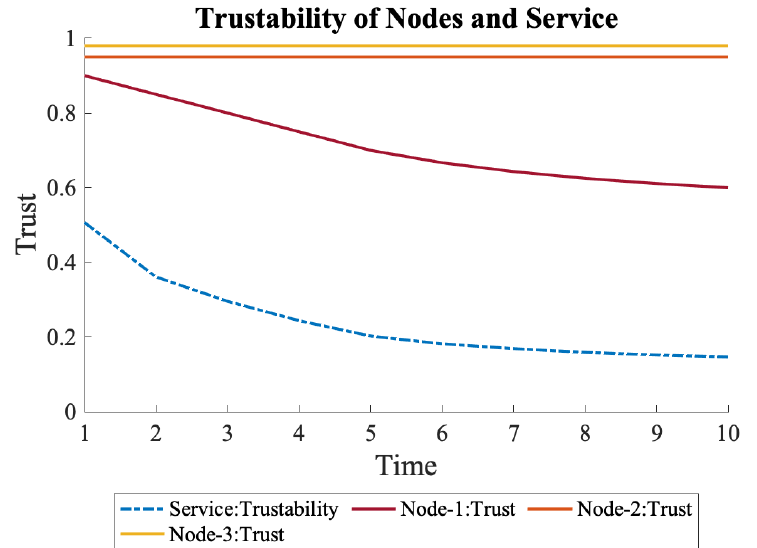
Figure 10. Trustability of a service running on three nodes on the cloud. A decline in the trust of N1 causes a decline in overall trustability.